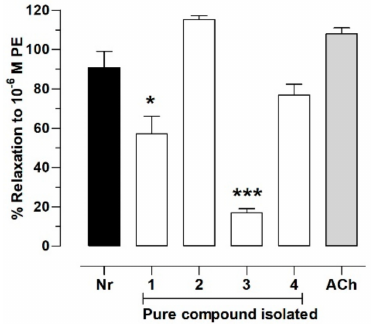
Figure 9. Screening test of 4 pure compounds of N. ramosissima on vascular response in rat aorta. Relaxation e ff ect of extract 100 µ g / mL N. ramosissima (black bar; Nr), 4 pure compounds isolated (1–4; 10 − 4 M) and acetylcholine (ACh; 10 − 4 M) in intact aortic rings pre-constricted with 10 − 6 M PE. The compound 2 and 4 presented a similar relaxation than 100 µ g / mL N. ramosissima extract. Values are mean ± standard error of the mean of 4 experiments. Statistically significant di ff erences: * p < 0.05, *** p < 0.001 vs.